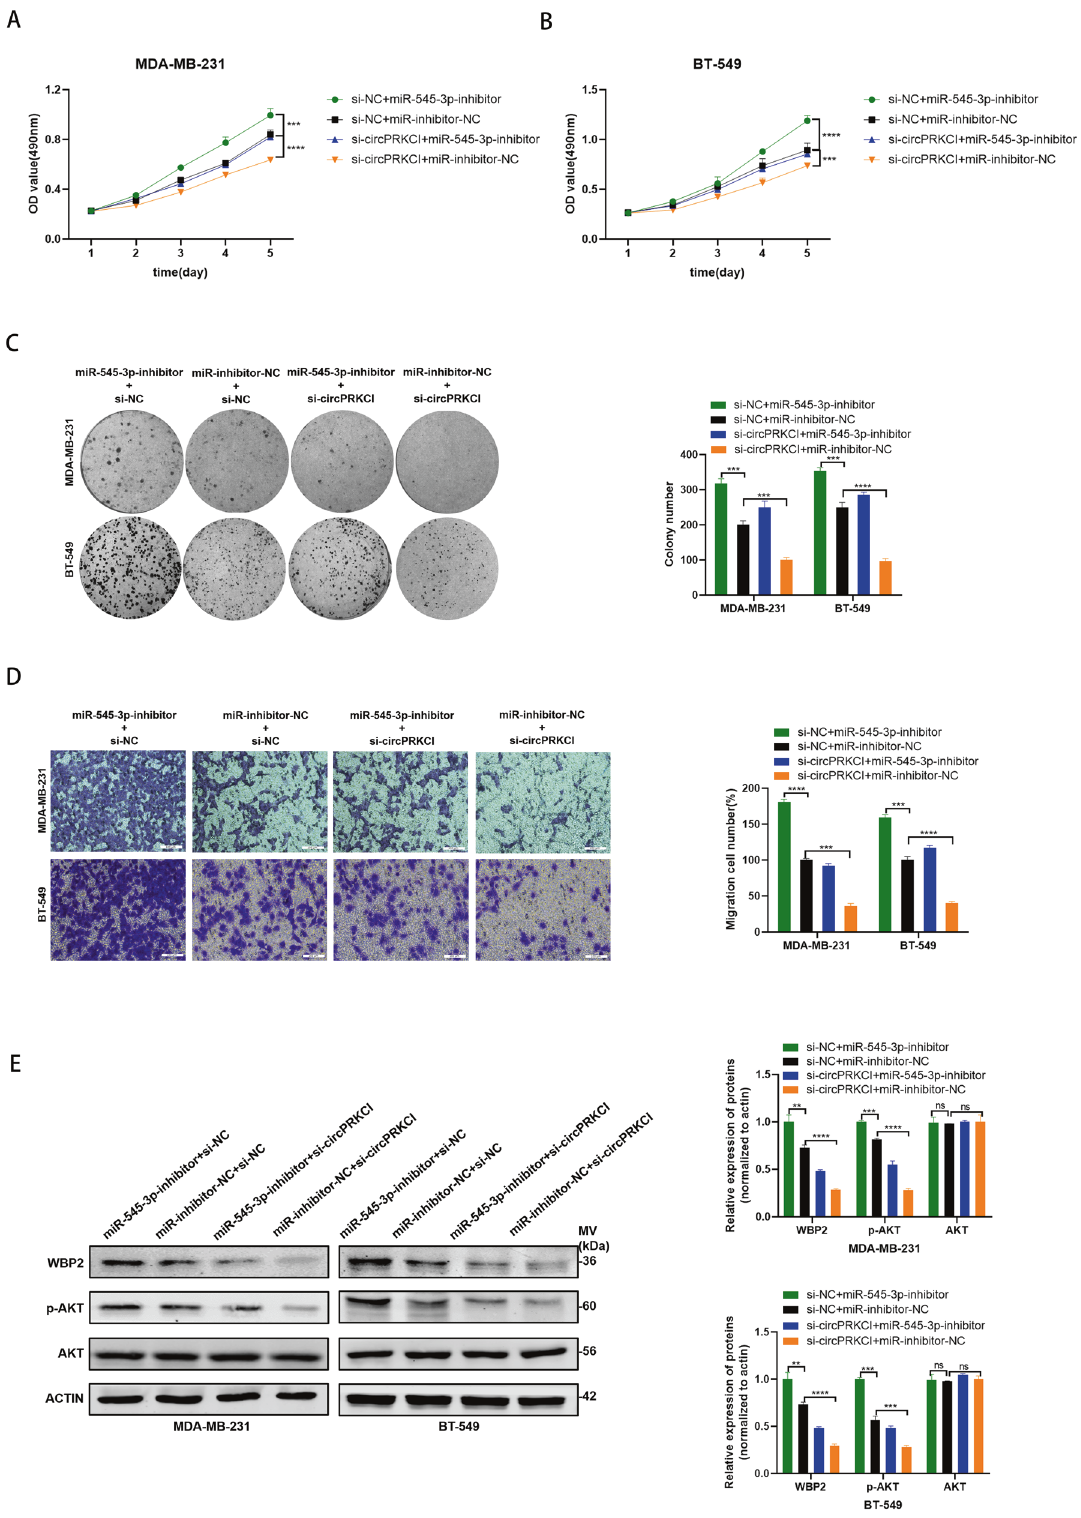
Fig. 6 CircPRKCI promoted TNBC progression via miR-545-3p/WBP2 axis. A , B miR-545-3p-inhibitor rescued the promotive effects of circPRKCI in TNBC cells by MTT assay. C miR-545-3p-inhibitor rescued the promotive effects of circPRKCI in TNBC cells by colony formation assay. D miR-545-3p-inhibitor rescued the promotive effects of circPRKCI in TNBC cells by cell migration assay. E Western blotting showed that miR-545-3p-inhibitor can partly rescue the low expression of WBP2 and p-AKT caused by si-circPRKCI in TNBC cells. ** p < 0.01,*** p < 0.001, **** p < 0.0001.